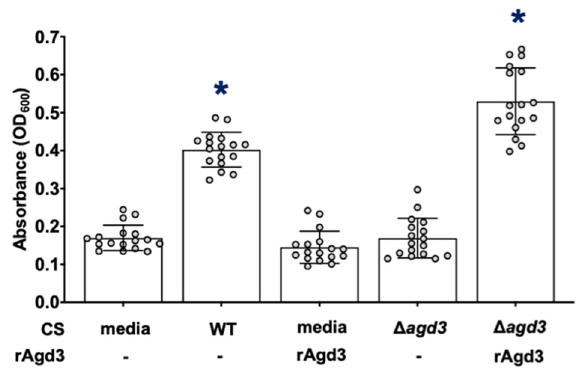
Figure 5. De- N -acetylated GAG is required to increase adherent biofilm formation by Pel-deficient P. aeruginosa . Adherent biofilm formation by Pel-deficient P. aeruginosa ( ∆ pelA ) grown in the presence of de- N -acetylated GAG from WT de- N -acetylated GAG-containing CS (WT CS), 130 nM recombinant Agd3 deacetylase enzyme (rAgd3) or N -acetylated GAG from N -acetylated-GAG-containing culture supernatants ( ∆ agd3 CS), or de- N -acetylated GAG from a combination of N -acetylated-GAG-containing culture supernatants and 130 nM rAgd3 ( Δ agd3 CS + rAgd3) was quantified with crystal violet staining. Bars represent the means ± standard deviations of 3 independent experiments. A significant increase in absorbance is indicated by * ( p < 0.0001) relative to all bars as determined by one-way ANOVA with Tukey’s multiple-comparison test.